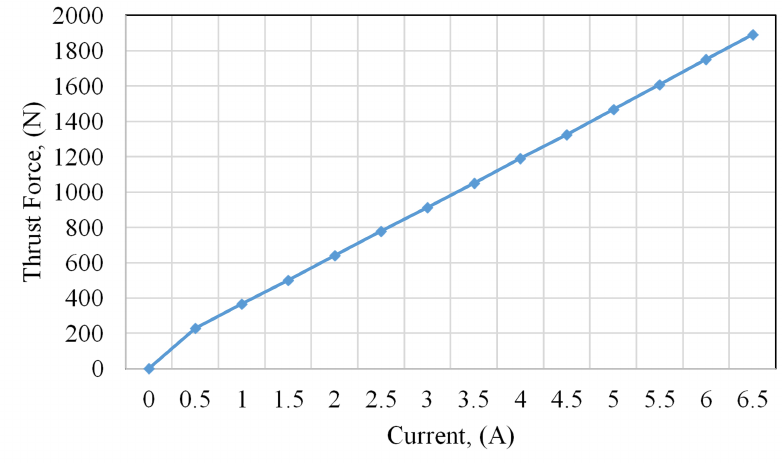
Figure 12. Thrust force verses q-axis